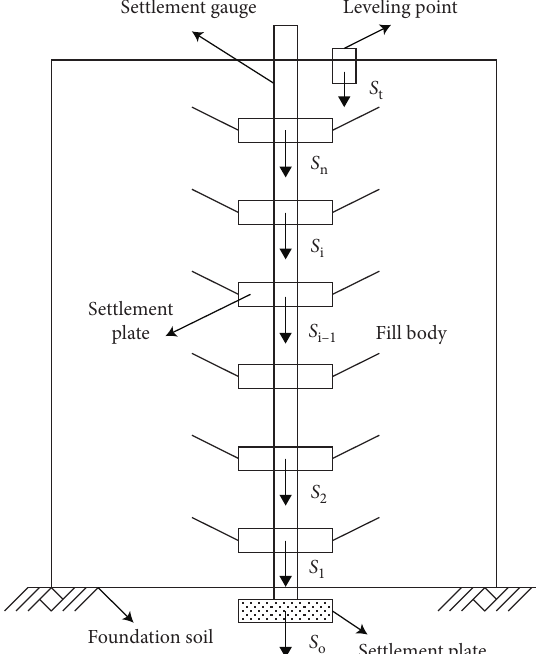
Figure 11: Layout of surface and deep-layered settlement moni- toring